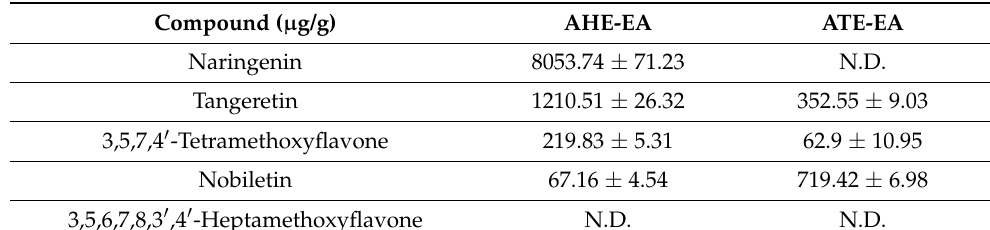
Table 4. Chemical composition analysis of flavonoid compounds of ATE-EA and AHE-EA by HPLC.